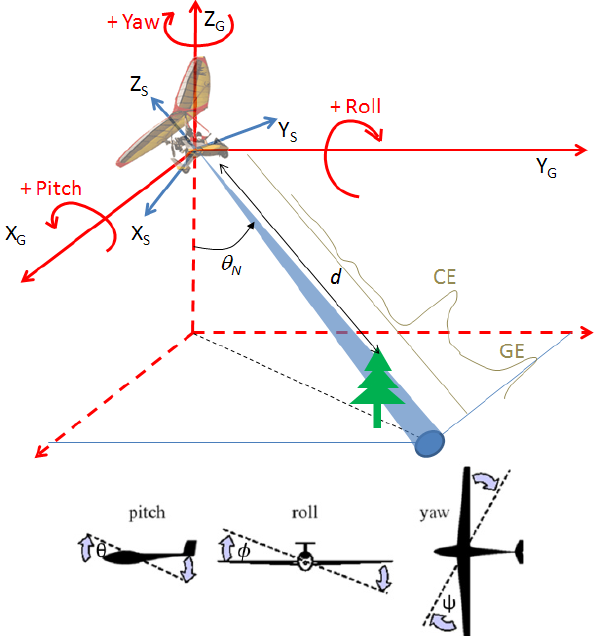
Figure A1. Representation of three angles (yaw, pitch and roll) between the actual lidar line of sight and the nadir direction. Both the sensor-fixed coordinate system ( Xs , Y and the local tangent plane coordinate system (X defined between the echo ( i.e. , CE or GE) and the